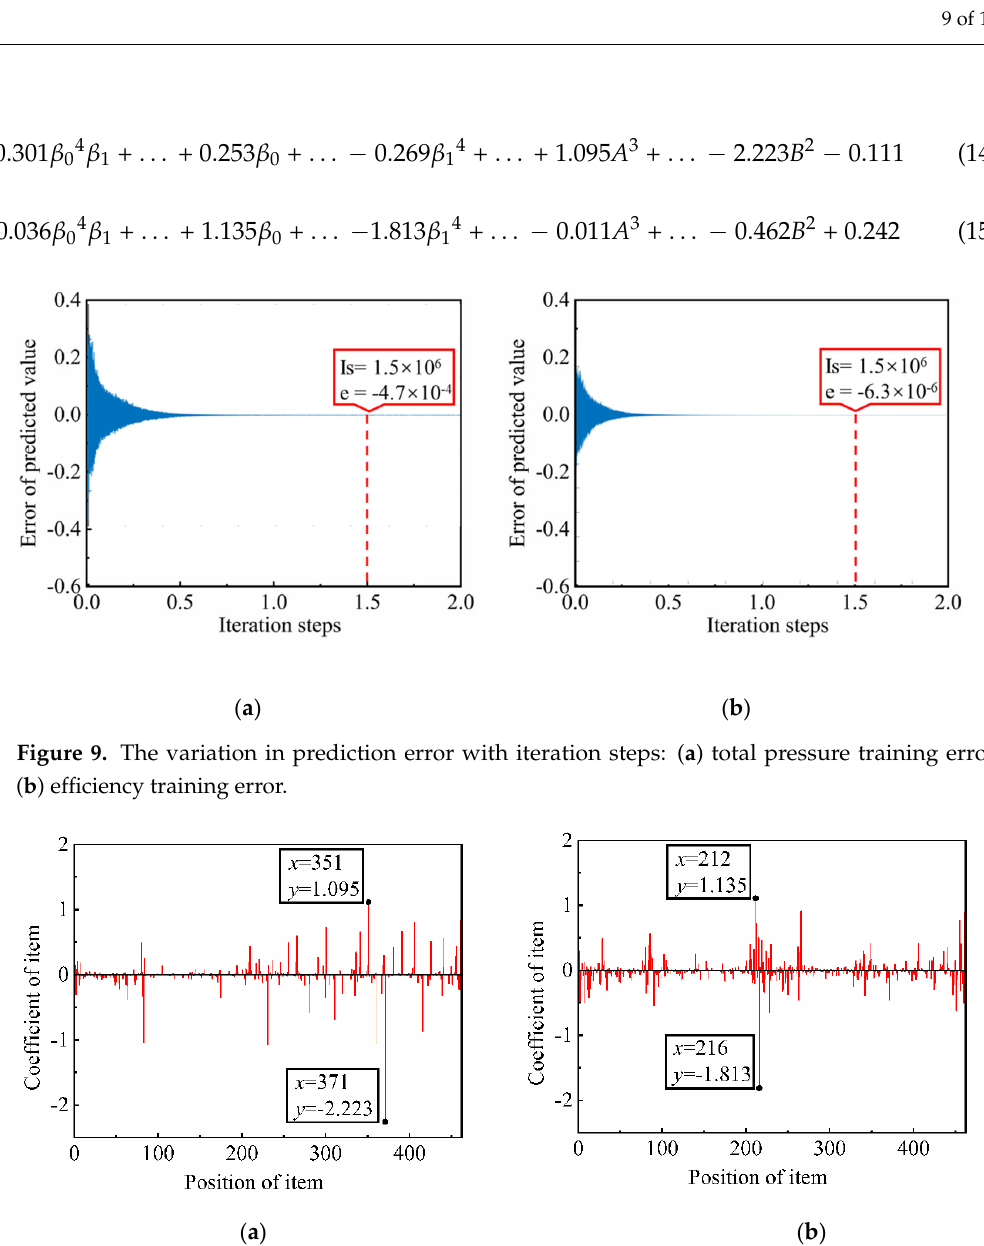
Figure 10. The relation spectrum: ( a ) the relation spectrum of total pressure coefficient; ( b ) the relation spectrum of efficiency. Table 4. Position of